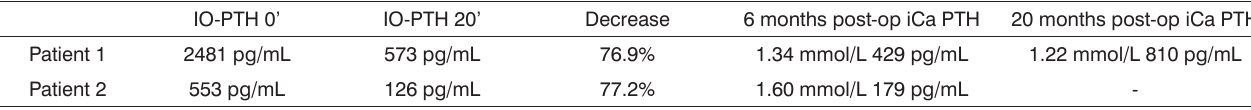
Table 4. Patients with 70-79% IO-PTH decrease who failure to cure.